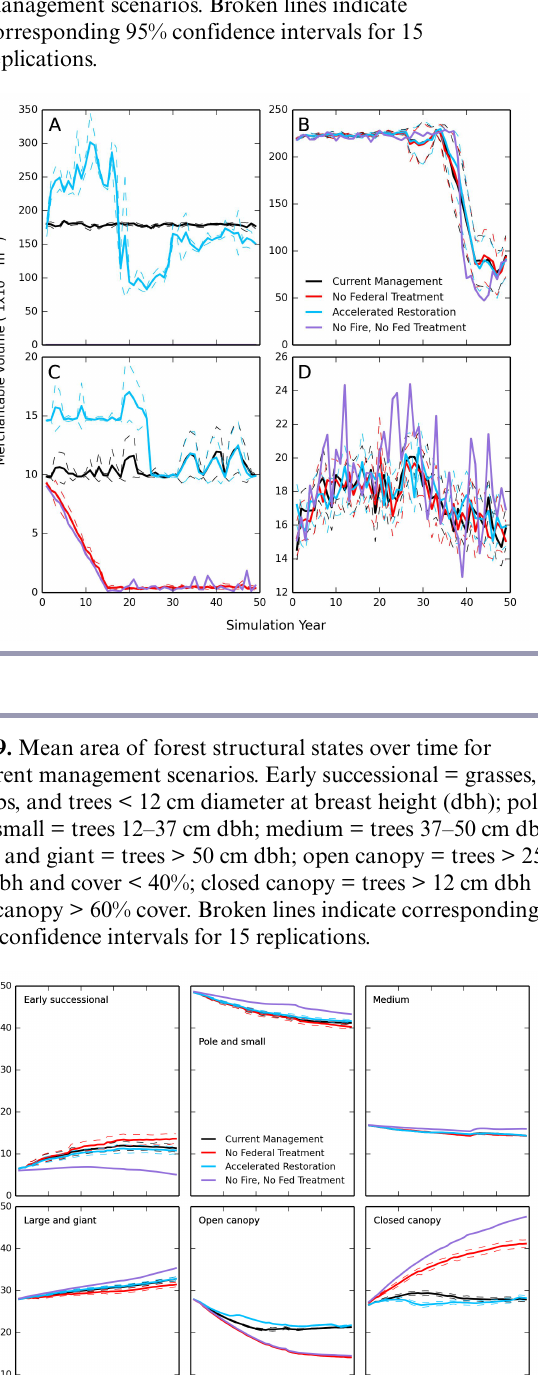
Fig. 7. Mean merchantable volume (A) and aboveground carbon (B) for all owners over time for different management scenarios. Broken lines indicate corresponding 95% confidence intervals for 15 replications.